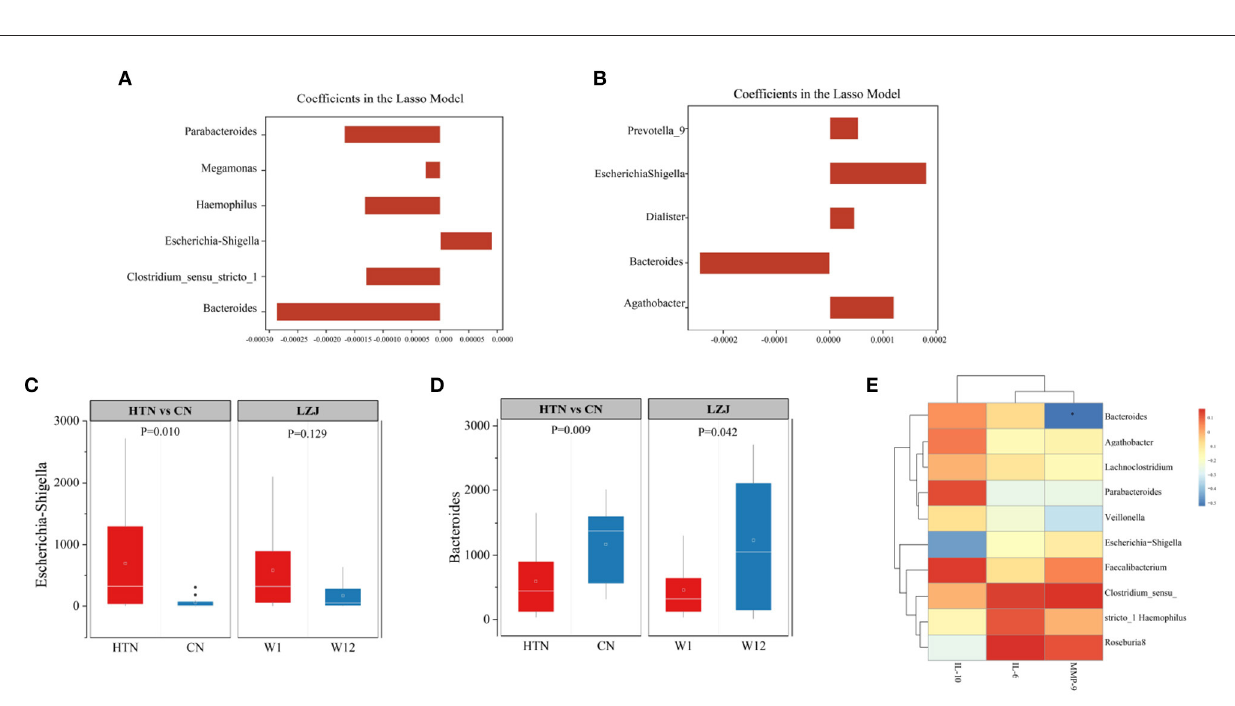
FIGURE7 Screening of differential microbiota after LZJ intervention. (A) Screening of differential microbiota of BP responders after LZJ intervention; (B) Screening of differential microbiota between BP responders and healthy people; (C, D) Abundance of Escherichia-Shigella, Bacteroidetes. The bar plots represent the regression in a model with binary output for every feature. Whiskers are drawn to minimum and maximum values, but not further than 1.5 × IQR; (E) Correlation analysis on immune stability and gut microbiota